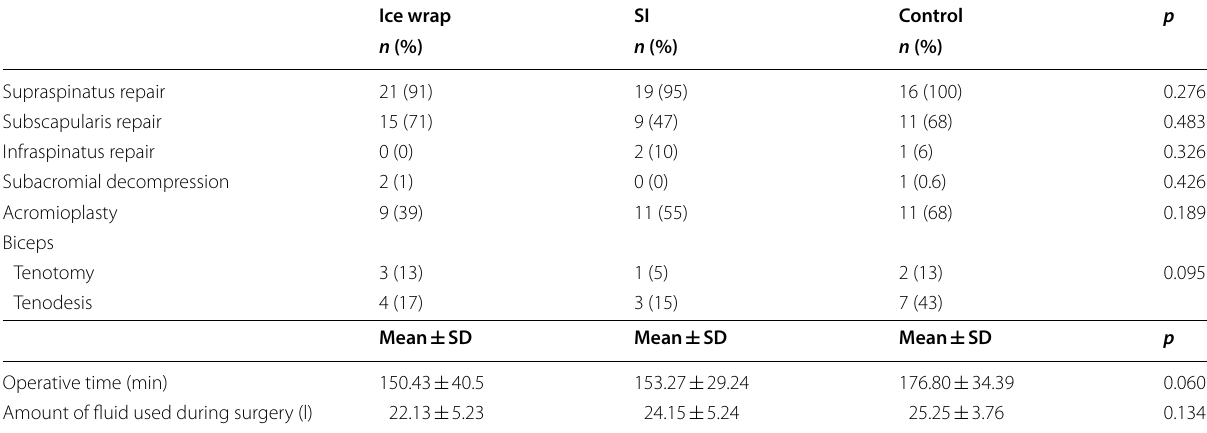
Table 2 Group comparison in terms of surgical procedures, operative time, and amount of fluid used during surgery Ice